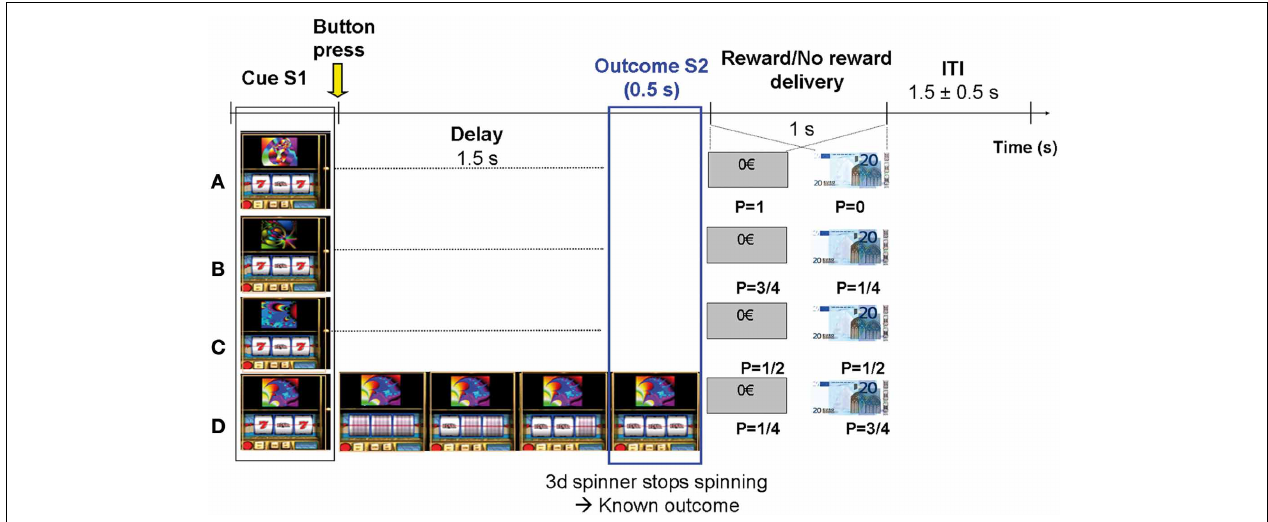
FIGURE 1 | Experimental paradigm. Subjects estimated the reward probability of 4 types of slot machines that varied with respect to monetary reward probabilities P (0, 0.25, 0.5, and 0.75). The slot machines could be discriminated by specific fractal images on top of them. Trials were self-paced and were composed of 4 distinct phases: (1) Slot machine presentation (S1): subjects pressed one of two response-keys to estimate whether the slot machine frequently delivered 20€ or not, over all the past trials; (2) Delay period